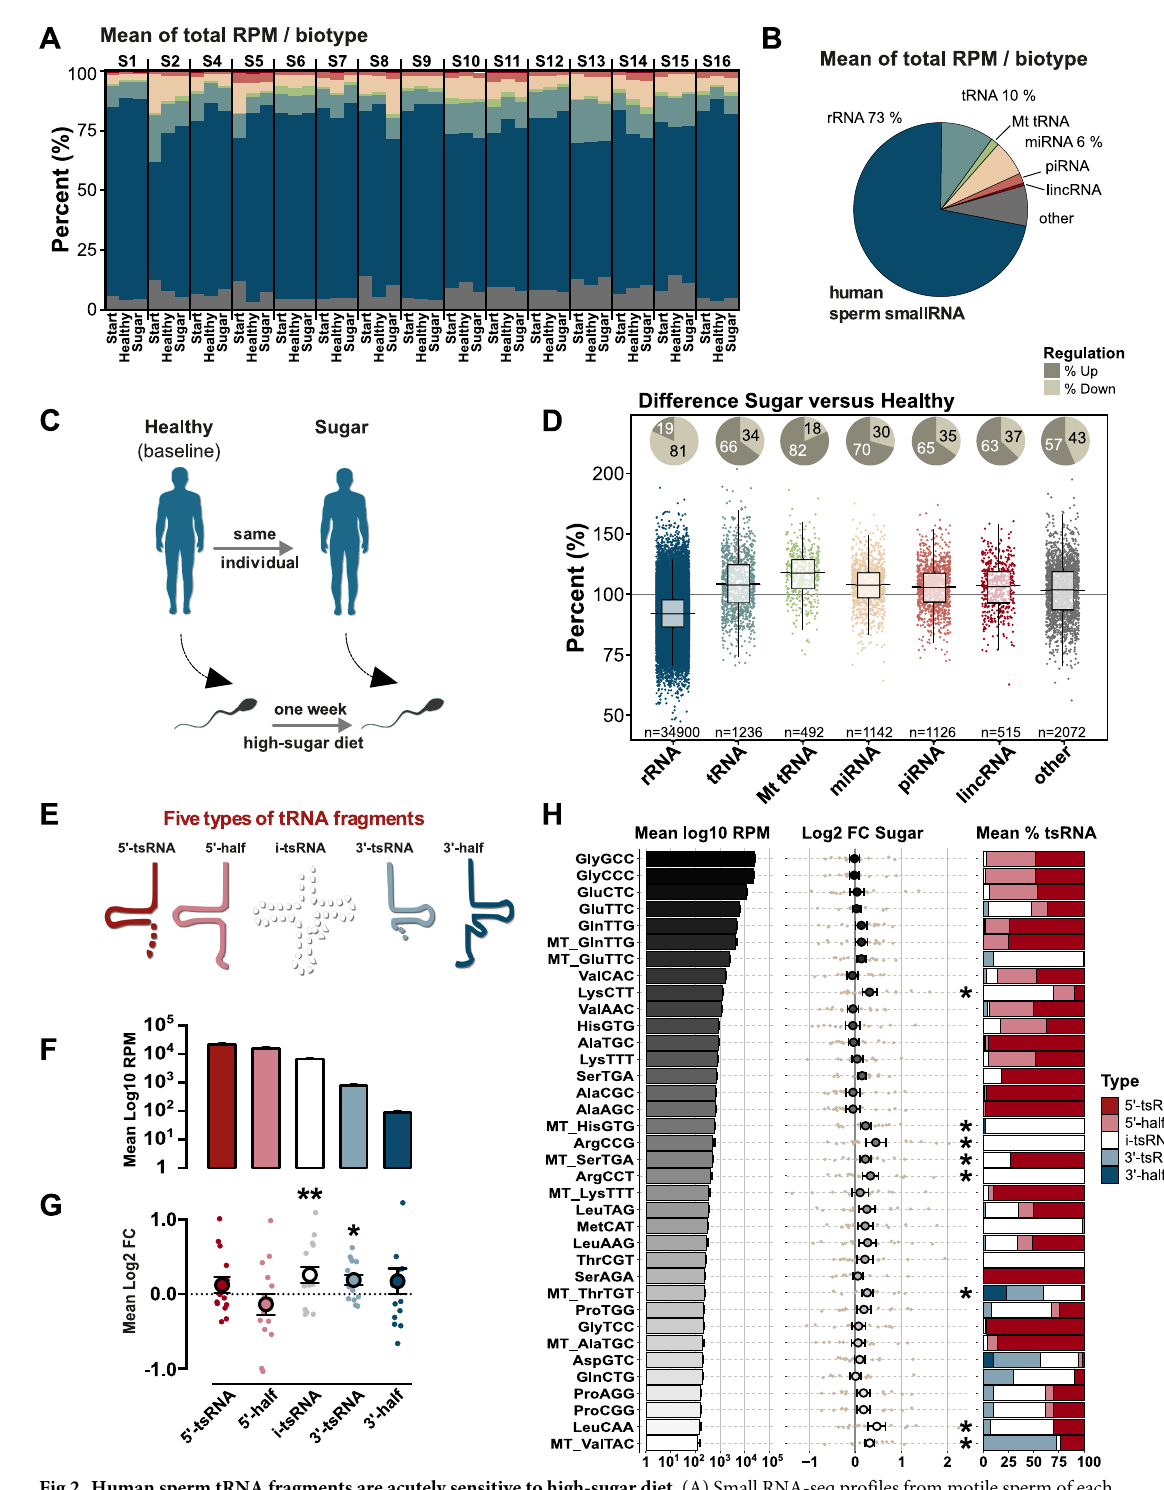
Fig 2. Human sperm tRNA fragments are acutely sensitive to high-sugar diet. (A) Small RNA-seq profiles from motile sperm of each participant (S1-S16; n = 15) were analyzed at the experimental start point (“Start”), after the first week of healthy diet (“Healthy”), and after the second week of high-sugar diet (“Sugar”). (B) Mean proportion of small RNA across the experiment. (C) The intervention was primarily designed for investigating the effect of Sugar compared to Healthy (baseline). (D) Fold changes in biotypes after 1 week of high-sugar diet (Sugar/Healthy). (E) Types of tsRNA analyzed. (F) Mean number of reads for the different types of tsRNAs. (G) Fold changes of tsRNA types